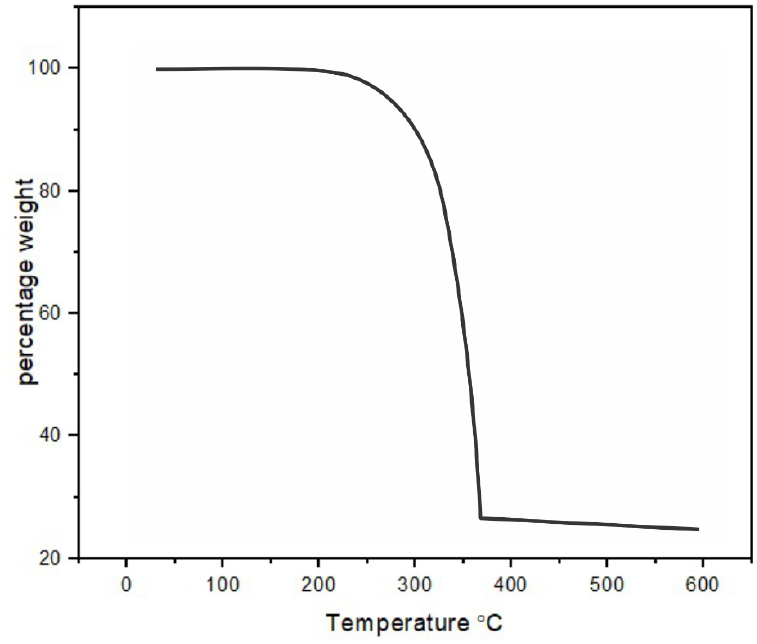
Figure 1. Thermogravimetric analysis graph of [Pb(iBu 2 PS 2 ) 2 ].